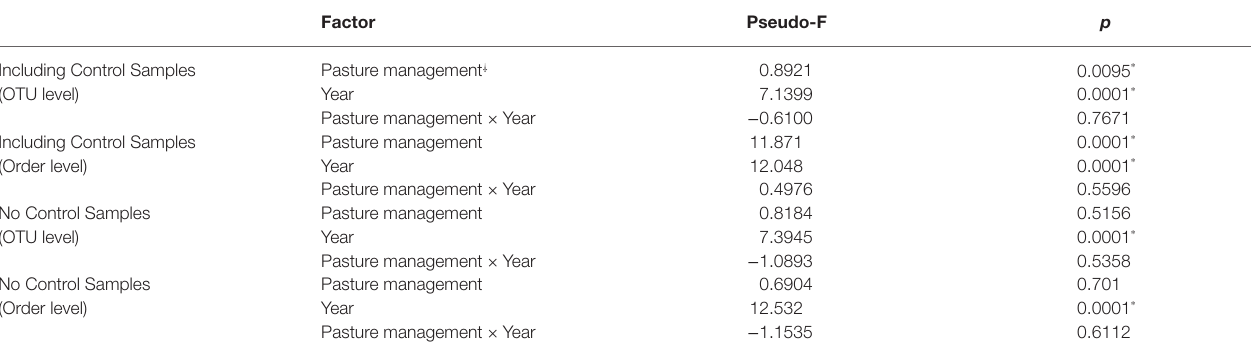
TABLE 2 | PERMANOVA in bacterial community structure by pasture management and year with or without non-agricultural samples (control). Factor